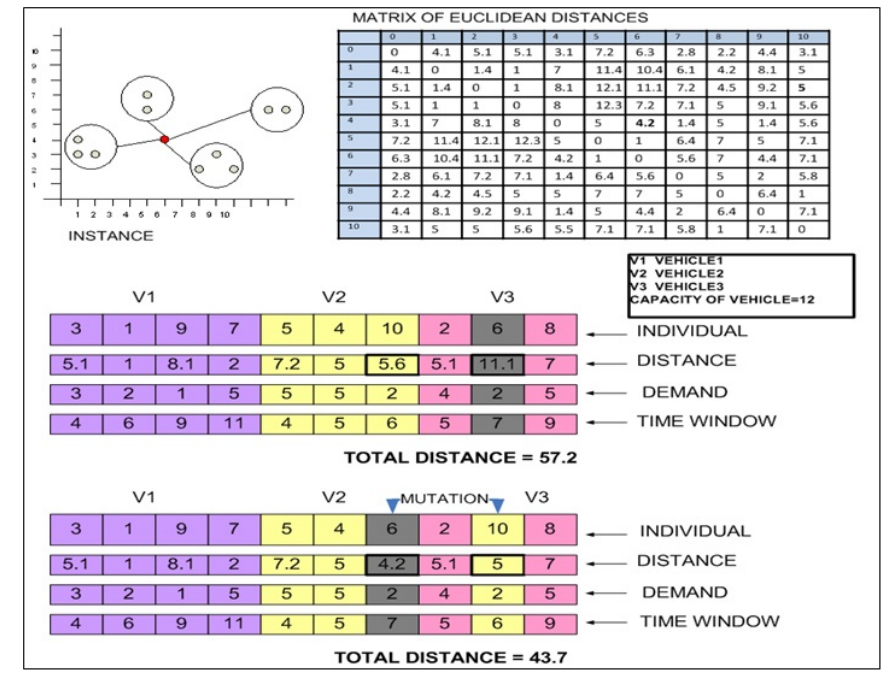
Figure 2. Mutation-s operator of the GA-VRPTW algorithm [1].